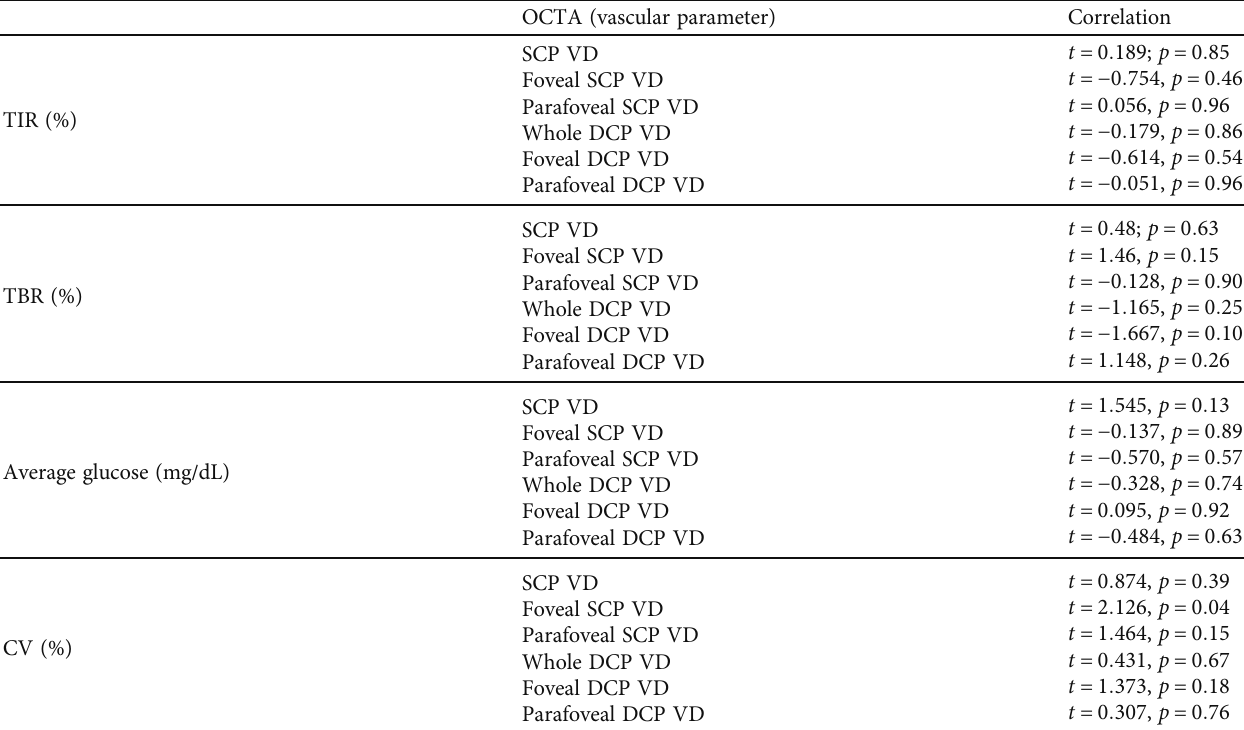
Table 3: Correlation between OCTA parameters and CGM-derived glucose metrics in type 1 diabetes.